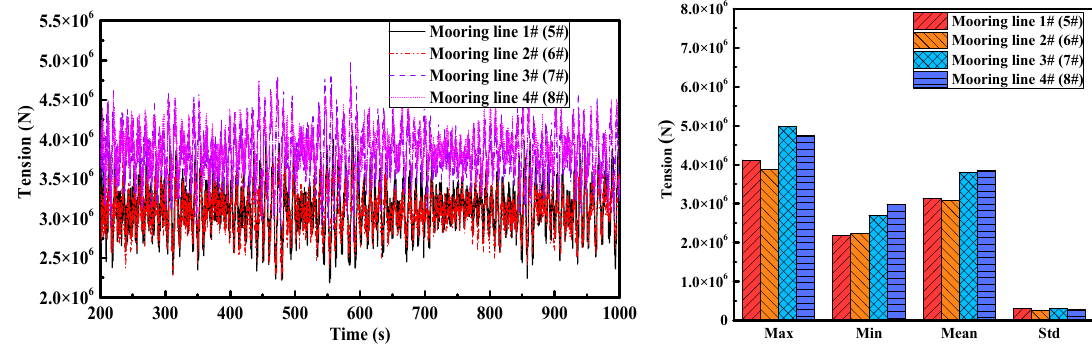
Figure 14. Time series and statistics of tether tensions.